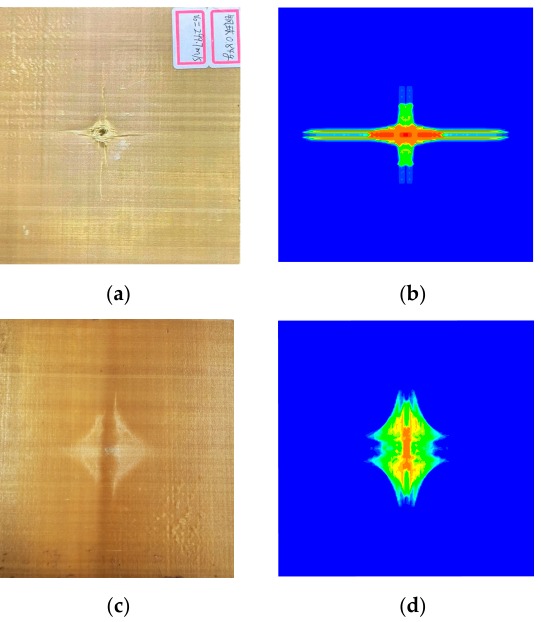
Figure 13. ( a ) Experimental result of the front surface; ( b ) PD simulation result of the front surface; ( c ) Experimental result of the rear surface; ( d ) PD simulation result of the rear surface.